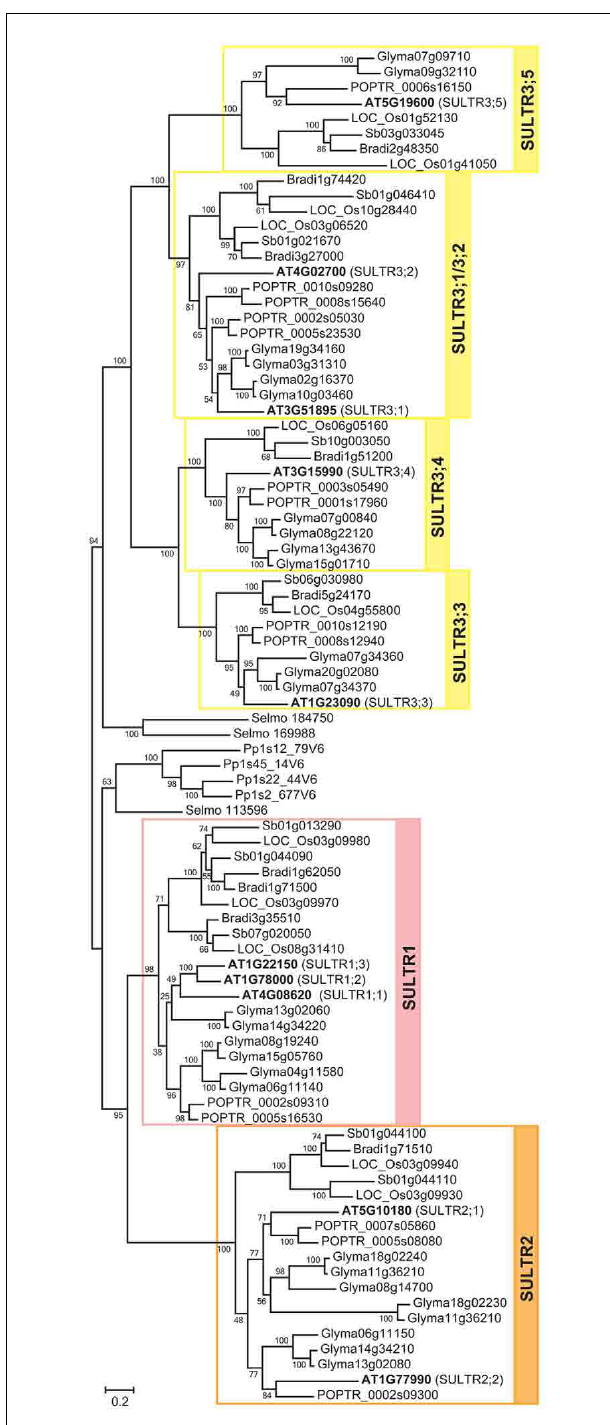
FIGURE 3 | Expansion of SULTR1–SULTR3 subfamilies in plants. The phylogenetic tree indicates expansion of the SULTR1/2/3 lineage ( Figure 2 ) in seed plants.The SULTR1, SULTR2, and SULTR3 subfamilies are highlighted in pink, orange, and yellow, respectively.The bootstrap values are shown at the nodes.The locus numbers or gene IDs are described the same as in Figure 2 .The names of Arabidopsis sulfate transporters are shown in the parentheses next to the locus